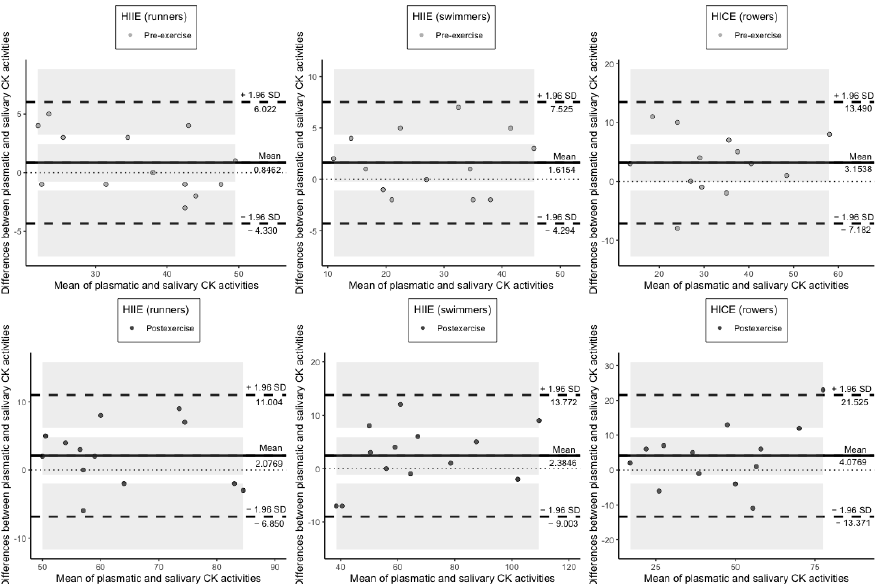
Figure 6. Plots of difference between the measurements of CK activity in plasma and saliva vs. the mean of the measurement. The bias (mean difference) is represented by a solid line parallel to the X axis. The limits of agreement are represented by the dashed lines parallel to the X axis at − 1.96 and +1.96 SD. Shaded areas present confidence interval limits for mean and agreement limits. CK: crea- tine kinase; HIIE: high-intensity interval exercise; HICE: high-intensity continuous exercise; SD: standard deviation.